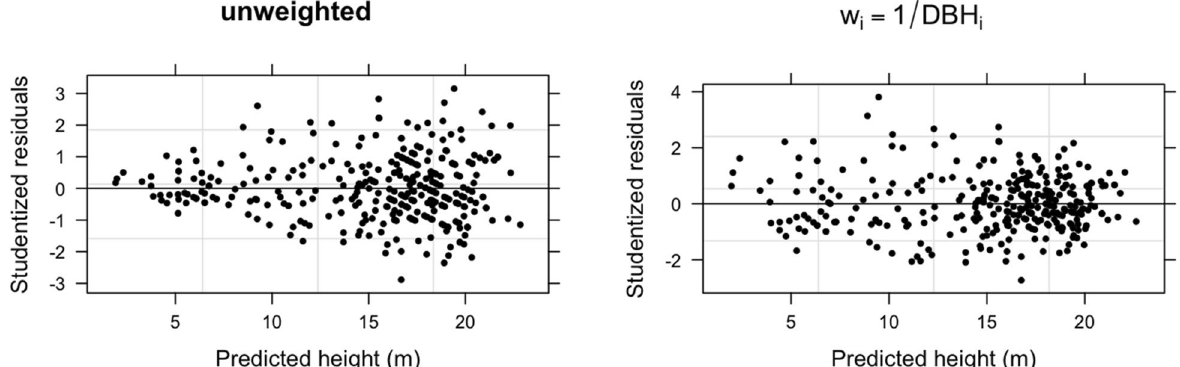
Fig. 15 The plot of studentized residuals against the predicted height for N. pumilio . The studentized residuals were obtained by fitting model Eq. 3 without weighting (left) and with weighting factor w i = 1 ∕ DBH i (right)